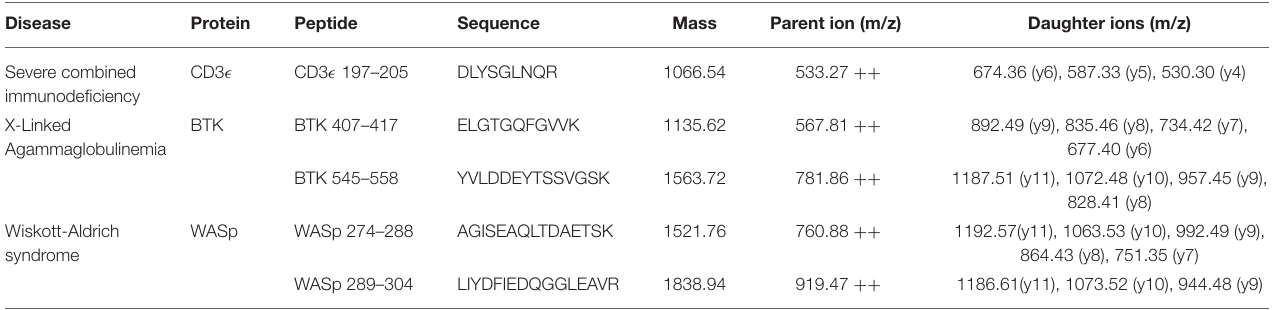
TABLE 2 | Protein targets and sequences used for immuno-SRM study. Disease